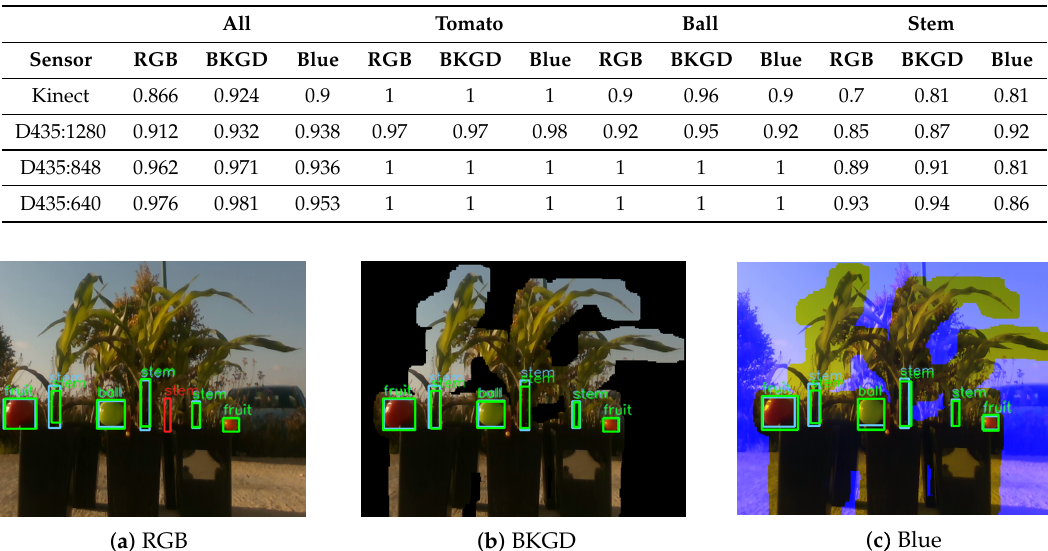
Table 5. mAP results for object identification incorporating depth information for all object types. RGB denotes using only the RGB data, BKGD denotes background removal prior to identificaiton, and Blue denotes replacing the blue channel with depth information.